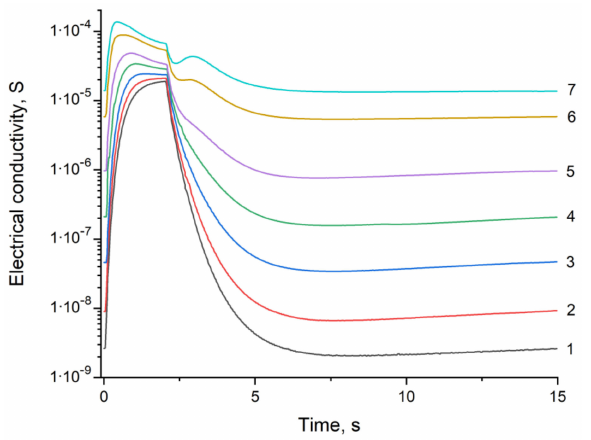
Figure 3. Change in electrical conductivity of the SnO 2 –PdO x sensor for hydrogen concentrations in air from 0 to 100 ppm (curves 1–7) during 1 measurement